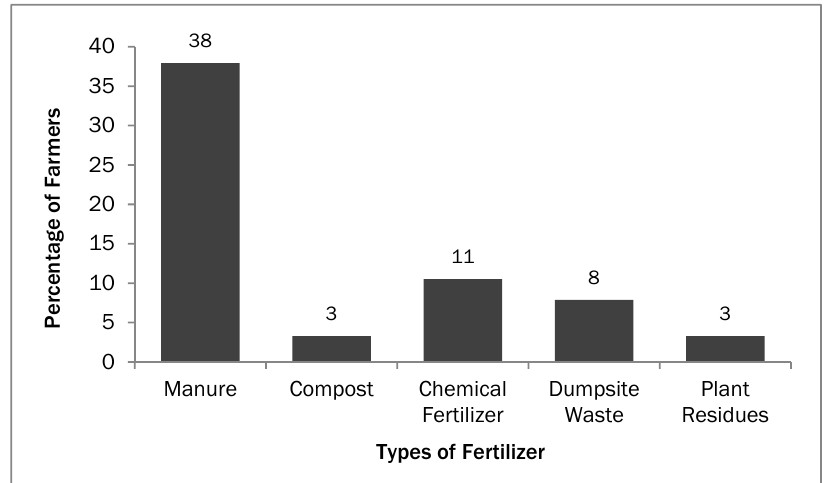
Figure 5. Fertilizer Use Among Farmers Many farmers in Kibera use fertilizer in their sack gardens, with animal manure being most commonly used ( n